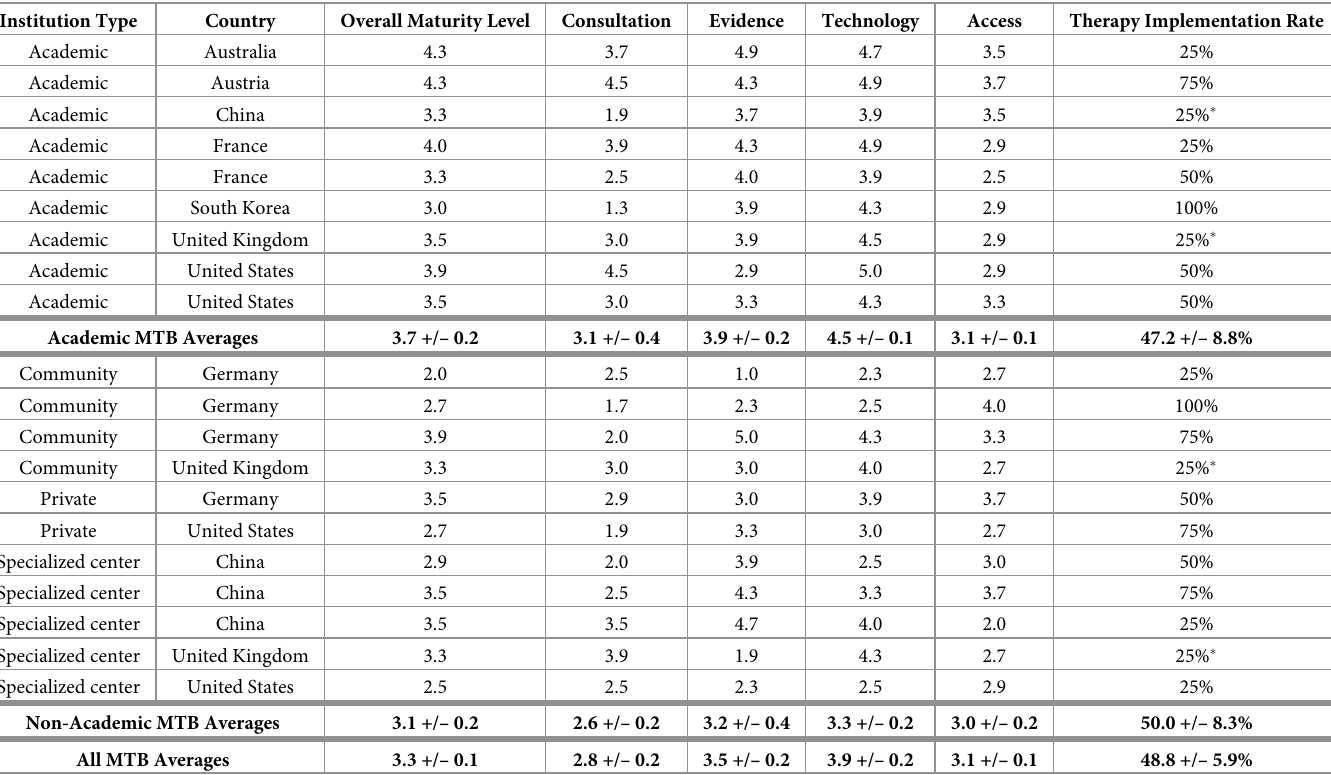
Table 4. ACTE-MTB maturity levels across 20 MTBs stratified by academic vs. non-academic institution